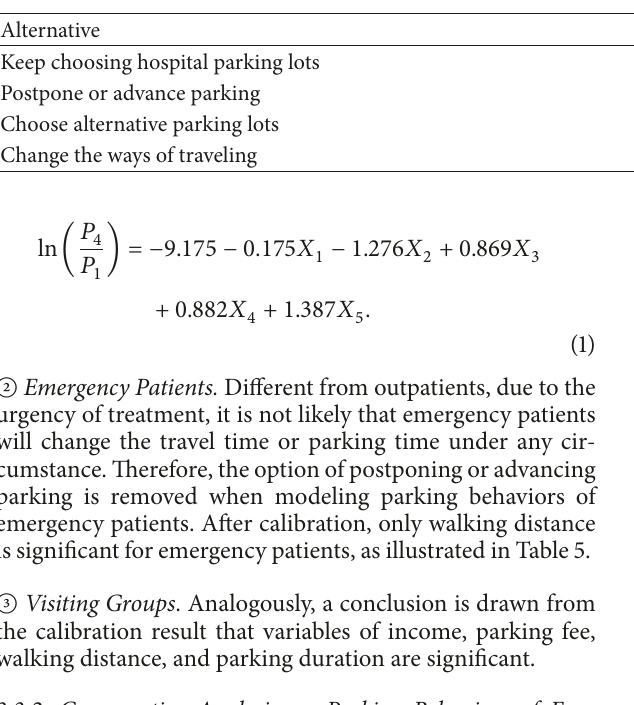
Table 4: Alternatives that three parking groups will